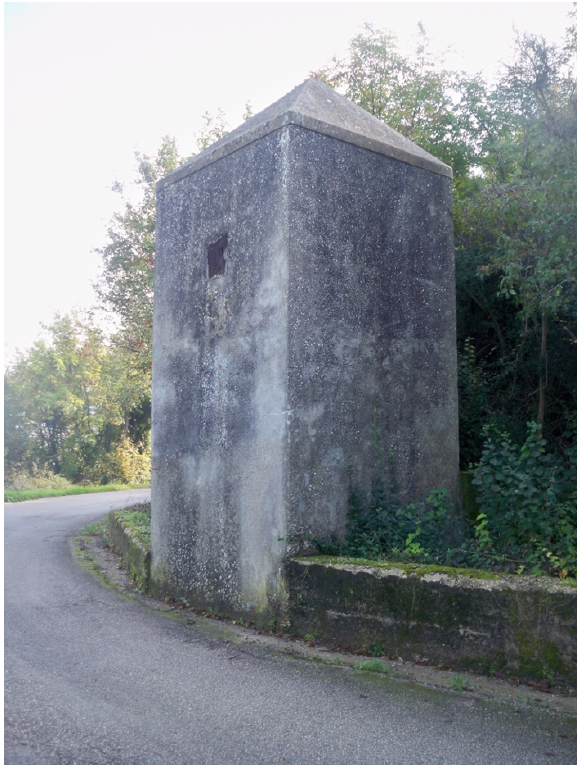
Figure 3 . ‘Carolino’ Aqueduct. Turret